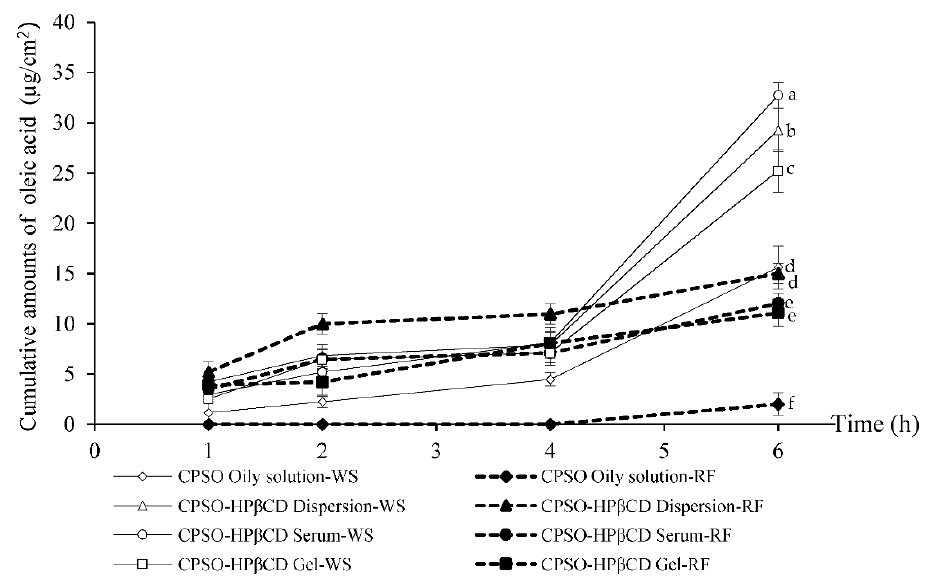
Figure 3. Cumulative amounts of oleic acid in various formulations of the C. paniculatus seed oil (CPSO) and hydroxypropyl- β -cyclodextrin inclusion complex (HP β CD) in the whole skin (WS) and receptor fluid (RF) within six hours. At six hours, mean cumulative amounts with the same letter are not significantly different. Thus, means with different letters (e.g., ‘a’ or ‘b’) were statistically different ( p < 0.05).